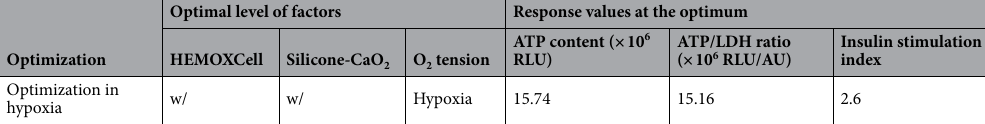
Table 3. Multi-response optimization for the screening